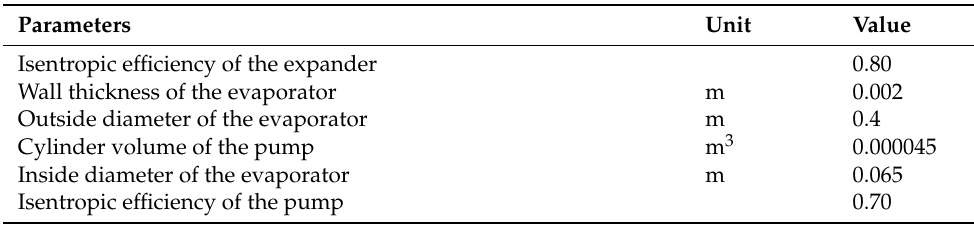
Table 1. Main parameters of the dynamic ORC model.